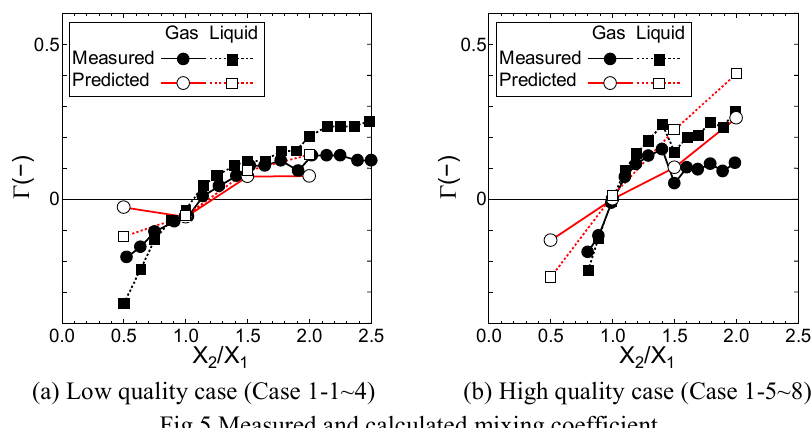
Fig.5 Measured and calculated mixing